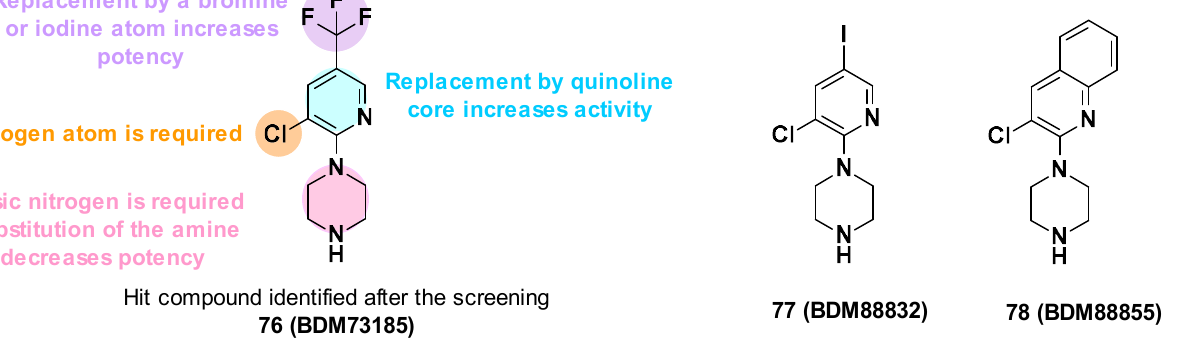
Figure 13. Summary of the SARs performed on BDM73185 ( 76 ) and structures of BDM88832 ( 77 ) and BDM88855 ( 78 ).